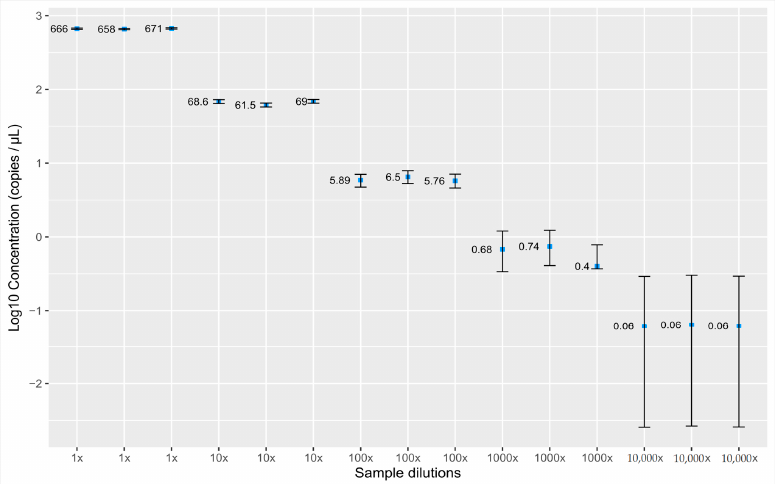
Figure 1. Linearity of the droplet digital PCR (ddPCR) assay for the quantification of cell-free DNA measured in triplicates in 10-fold dilutions over the five orders of magnitude. Dots represent mea- sured concentration (copies/ µ L), error bars represent Poisson’s distribution coefficient of variation.